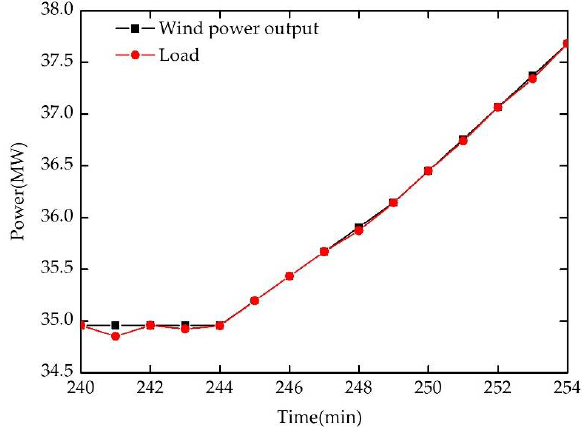
Figure 9. Wind power tracking comparison.